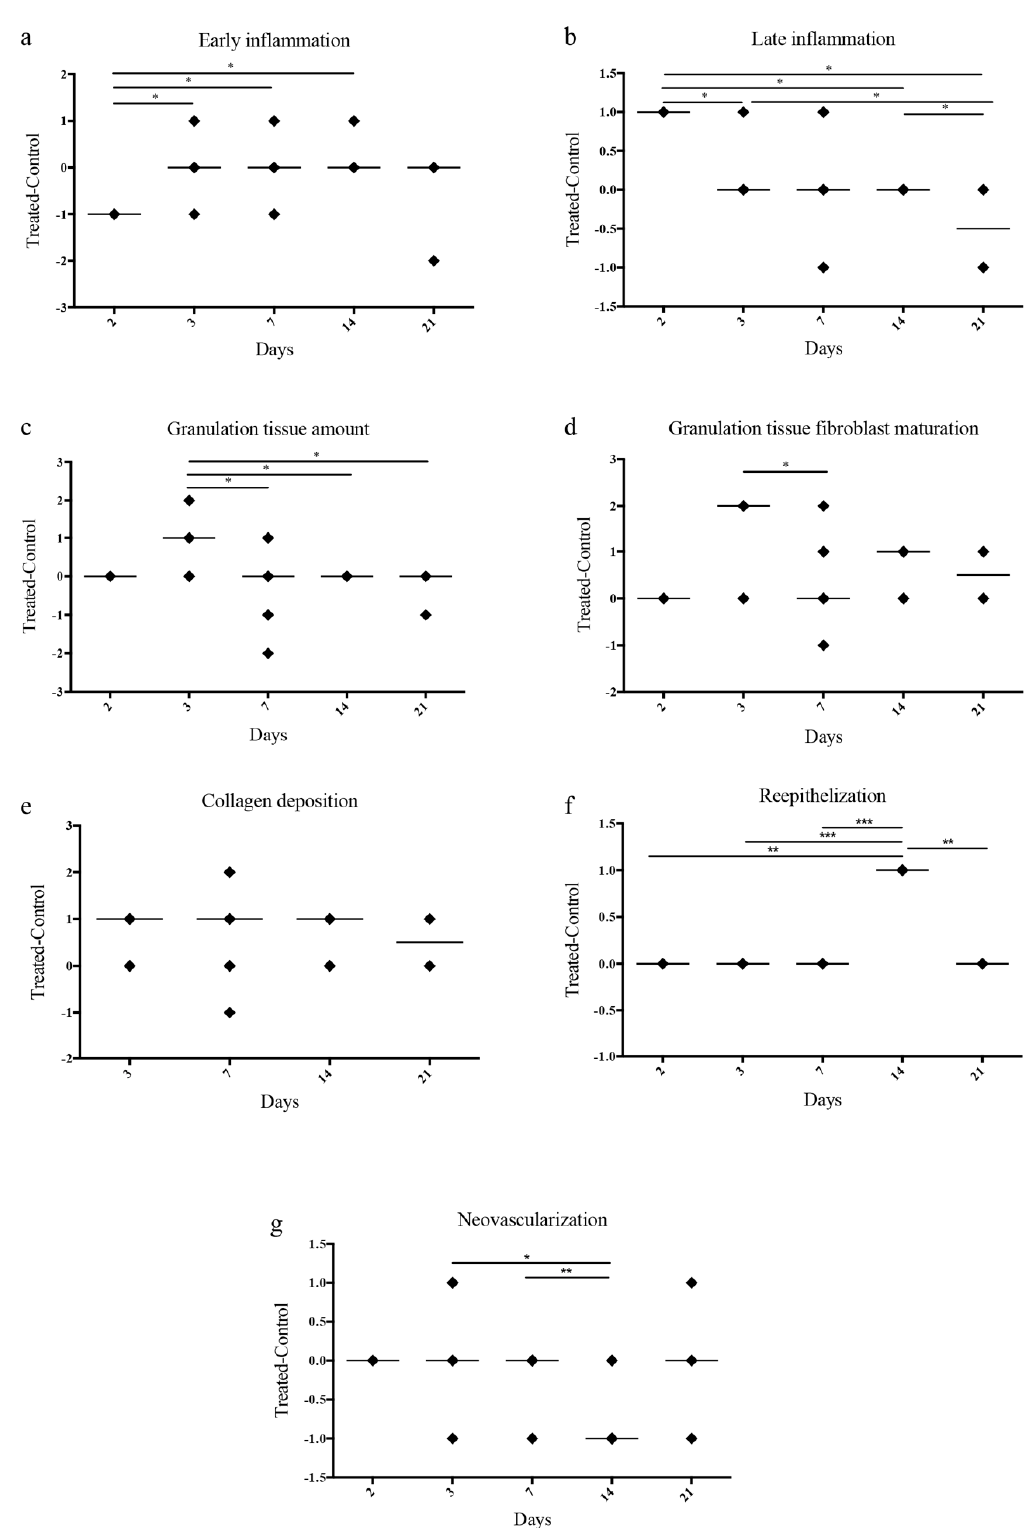
Figure 9. Quantification of histological parameters. Histology of the lesions treated with Alg/SS and Alg/SS/PL biomembranes; evaluation and statistical analyses of specific parameters suggested by Abramov et al. [24]: inflammation, defined in an early phase ( a ) and a late one ( b ); granulation tissue, intended as amount ( c ) and maturation of granulation tissue ( d ); collagen deposition ( e ); re-epithelialization ( f ) and neo-vascularization ( g ). All evaluations were reported in the plot as di ff erence between the PL treated and the control lesions, *** p < 0.001, ** p < 0.01, * p <